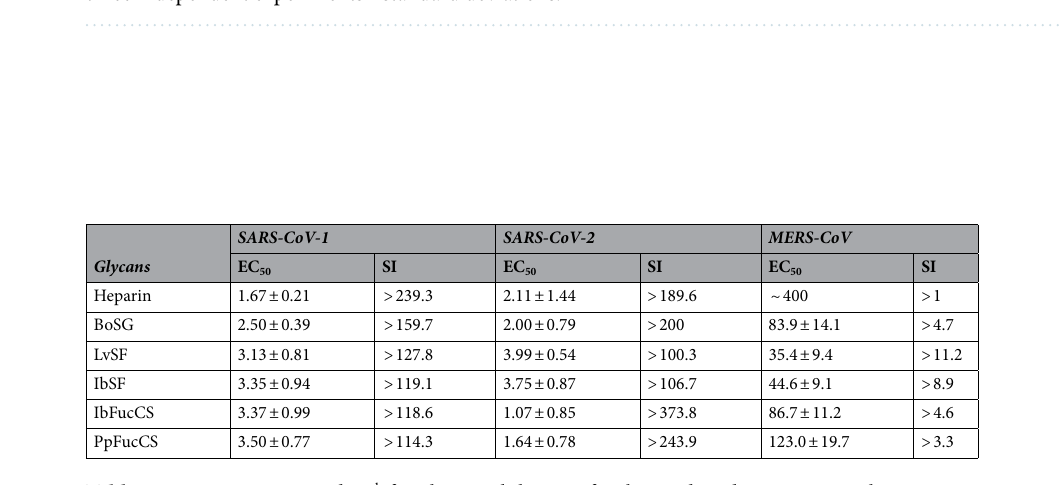
Table 1. EC 50 activities a and SIs b for glycan inhibition of spike-mediated VLP entry. a Glycan concentration (µg/mL) that reduces GFP signal by 50% following transduction of HEK-293T-hACE2 cells (SARS-COV-1 and SARS-CoV-2) or HeLa-DPP4 cells (MERS-CoV) with VLPs pseudotyped with spike proteins from the indicated viruses; data are means of three independent experiments ± standard deviations. b TC 50 /EC 50 , assigning TC 50 = 400 µg/mL for all